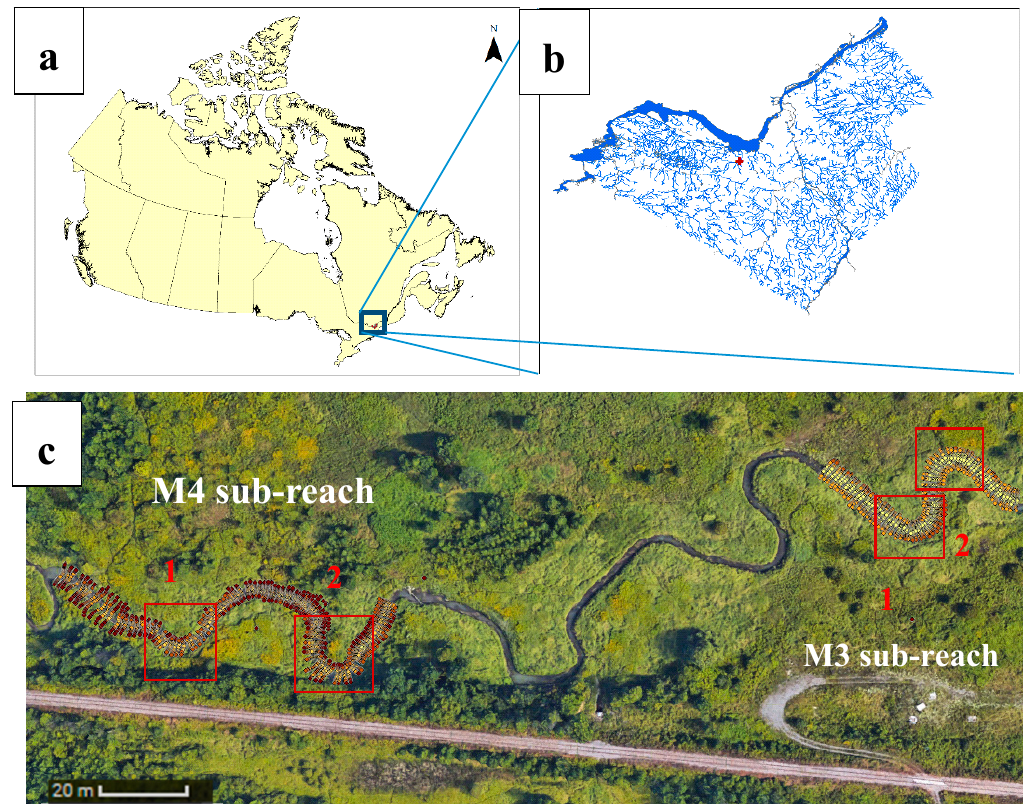
Figure 1. ( a ) Location of the study area within Canada (adopted from https://www12.statcan.gc.ca); ( b ) Study reach location in the Ottawa area (adopted from http://data.ottawa.ca/en/dataset/water); ( c ) Surveyed sections in Watts Creek sampling reaches M4 (to left) and M3 (to right) including total station surveyed points, flow from west (left) to east (right) (adopted from Google earth). Squares show the meander locations and their referred number within each sub-reach. Please note that the study area is situated at 45.340172° latitude, − 75.880610° longitude.